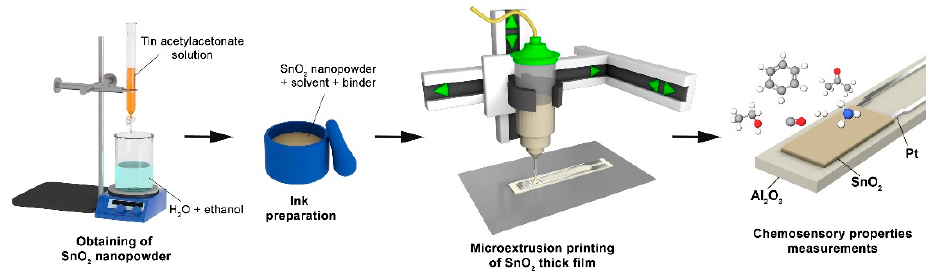
Figure 1. Scheme of SnO 2 thick film formation.